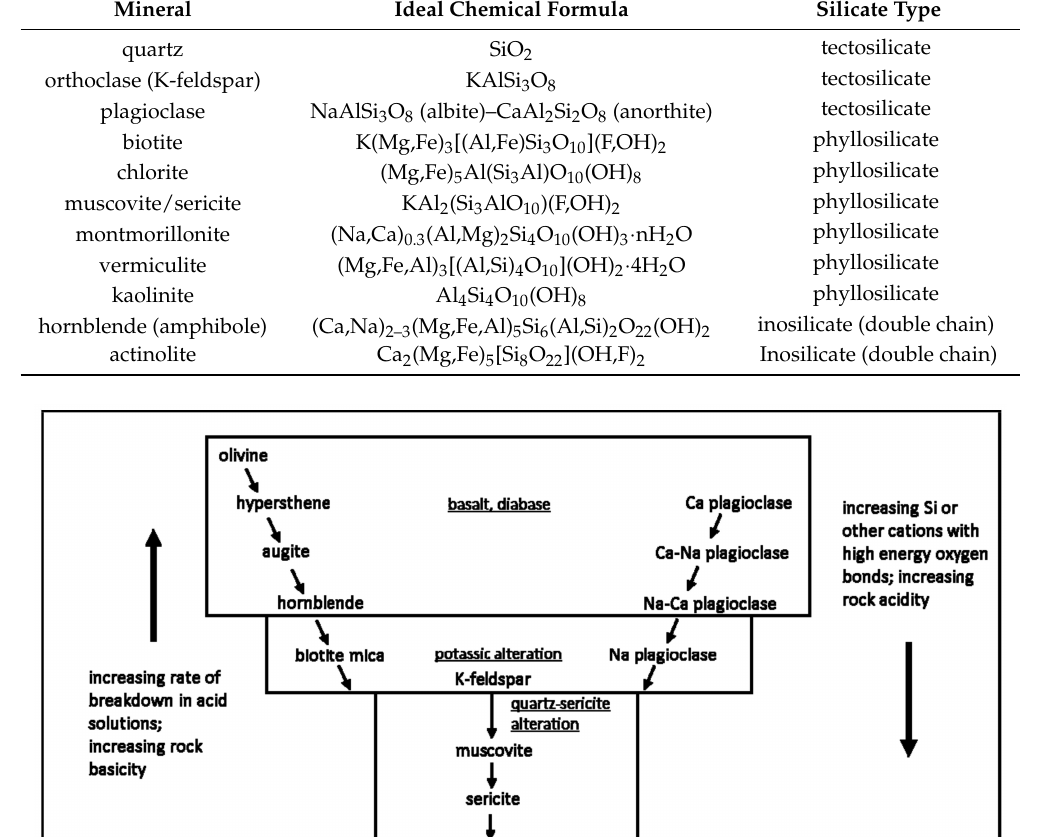
Table 1. Important silicate minerals present in porphyry copper deposits [8].